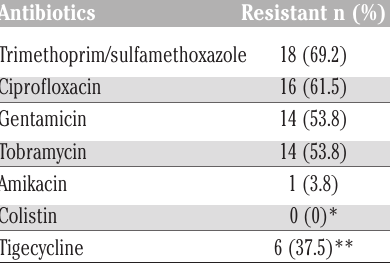
Table 1. Resistance to non-beta lactam antibiotics among Carbapenem Producing Enterobacteriaceae